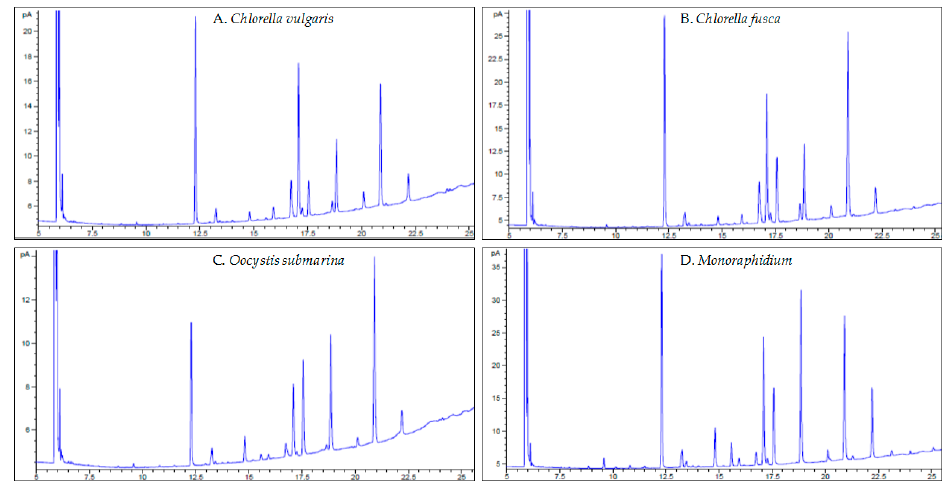
Figure 4. GC-FID chromatograms of fatty acids from particular microalgal strain.